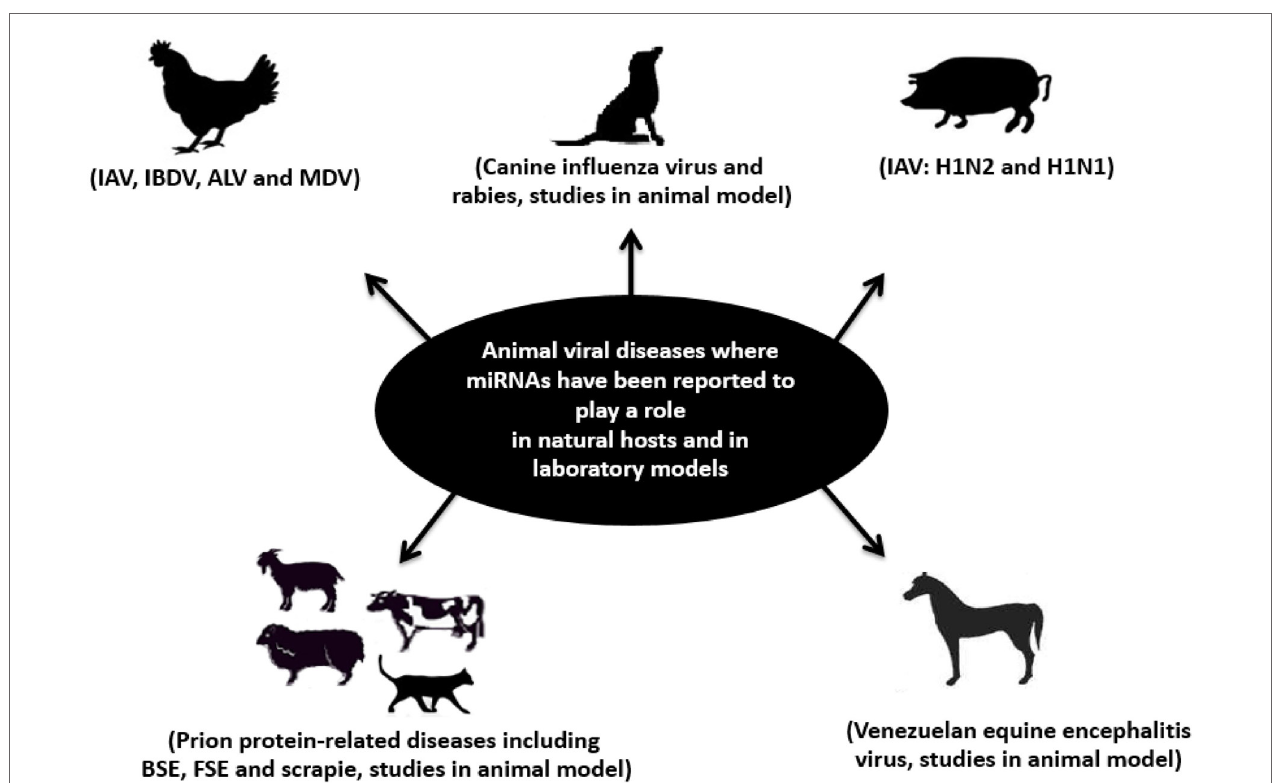
FiGURe 4 | Schematic representation of infectious viral diseases of farm and pet animals (in natural hosts and in laboratory models) where miRNAs have been reported to play a role . Examples of these diseases are bovine spongiform encephalopathy (BSE); feline spongiform encephalopathy (FSE); rabies; influenza A virus (IAV); infectious bursal disease virus (IBDV); Marek’s disease virus (MDV); avian leukosis virus (ALV); scrapie; and Venezuelan equine encephalitis (VEE). Adapted from Ref.